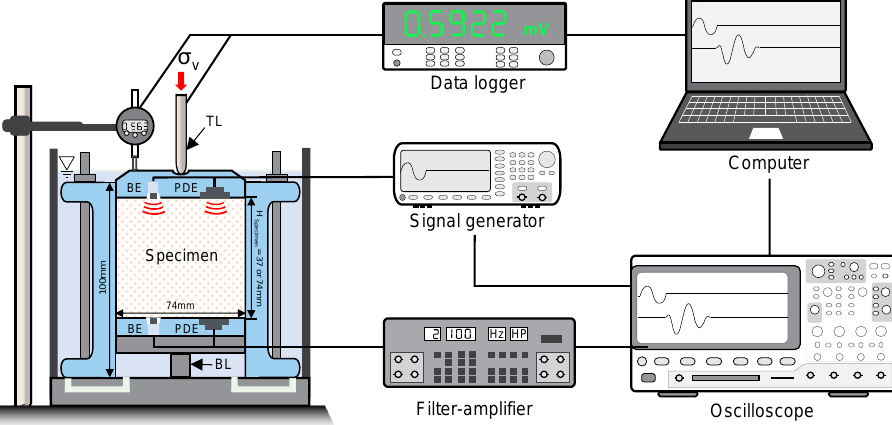
Figure 1. Schematic drawing of a modified oedometric cell with electronics. TL and BL denote the load cells installed at the top and bottom plates, respectively. In addition, BE and PDE denote the bender elements and piezo disk elements.